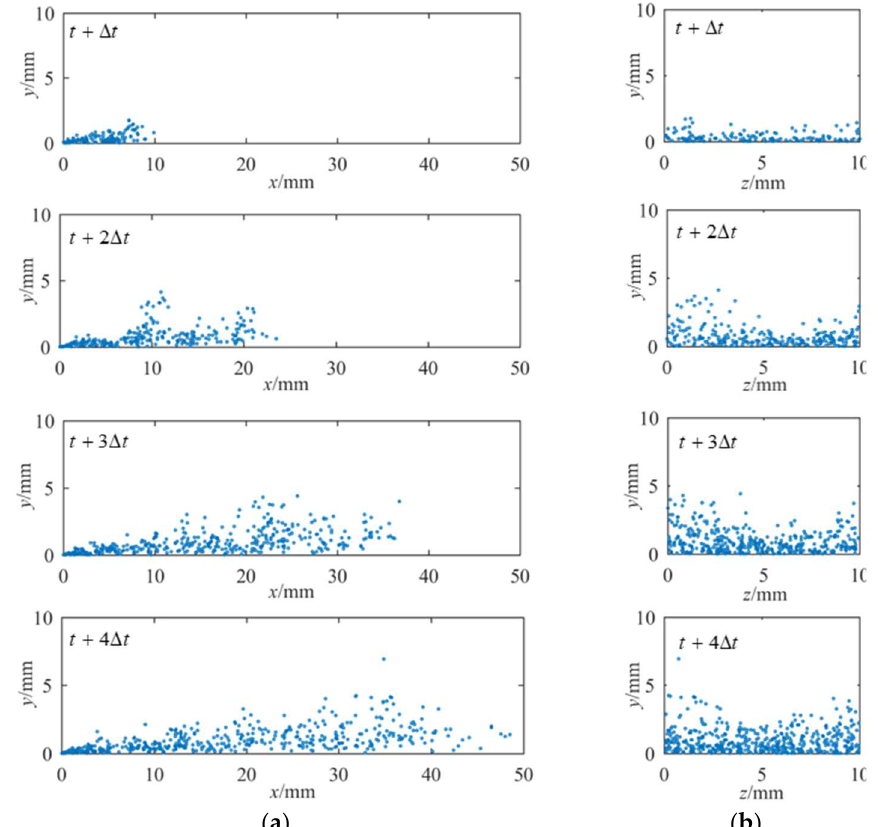
Figure 10. Distribution of microbubbles at four different moments. The quantity rate of microbubbles is 5 × 10 6 s −1 . Their size is set to a normal distribution with a standard deviation of 1.